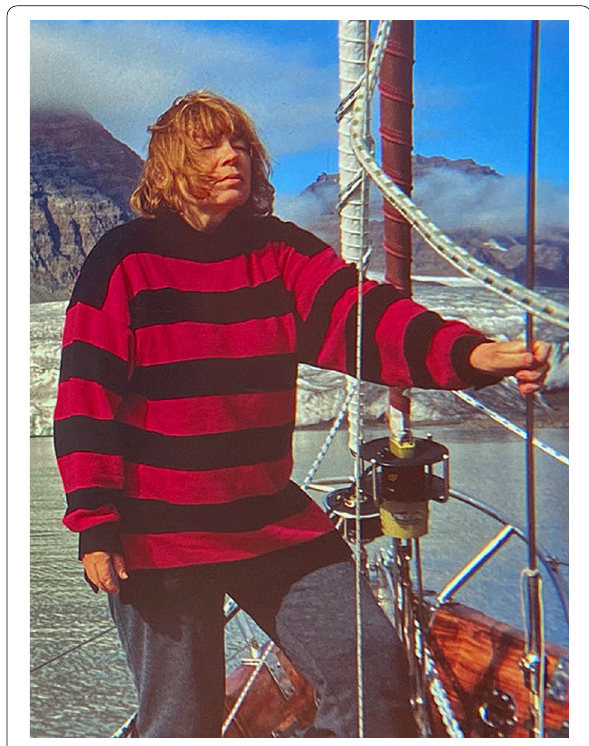
Fig. 18 Maria Olech, off the east coast of Greenland. Photo: Marian Gorlikowski